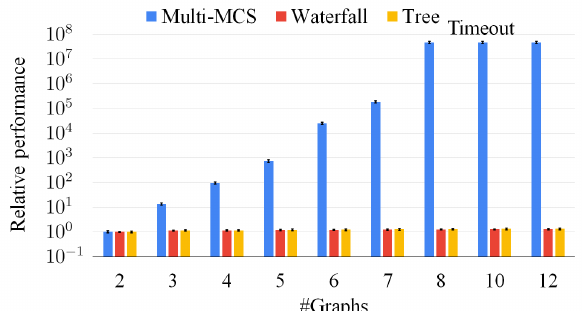
Figure 14. A comparison among the Multi-MCS, the waterfall, and the tree approaches on sets of graphs with an increasing number of graphs, varying from two to twelve. The plot reports the average solution time over 50 sets of graphs. The resolution time is normalized with respect to the solution time of pair of graphs. The y-axis adopts a logarithmic scale.